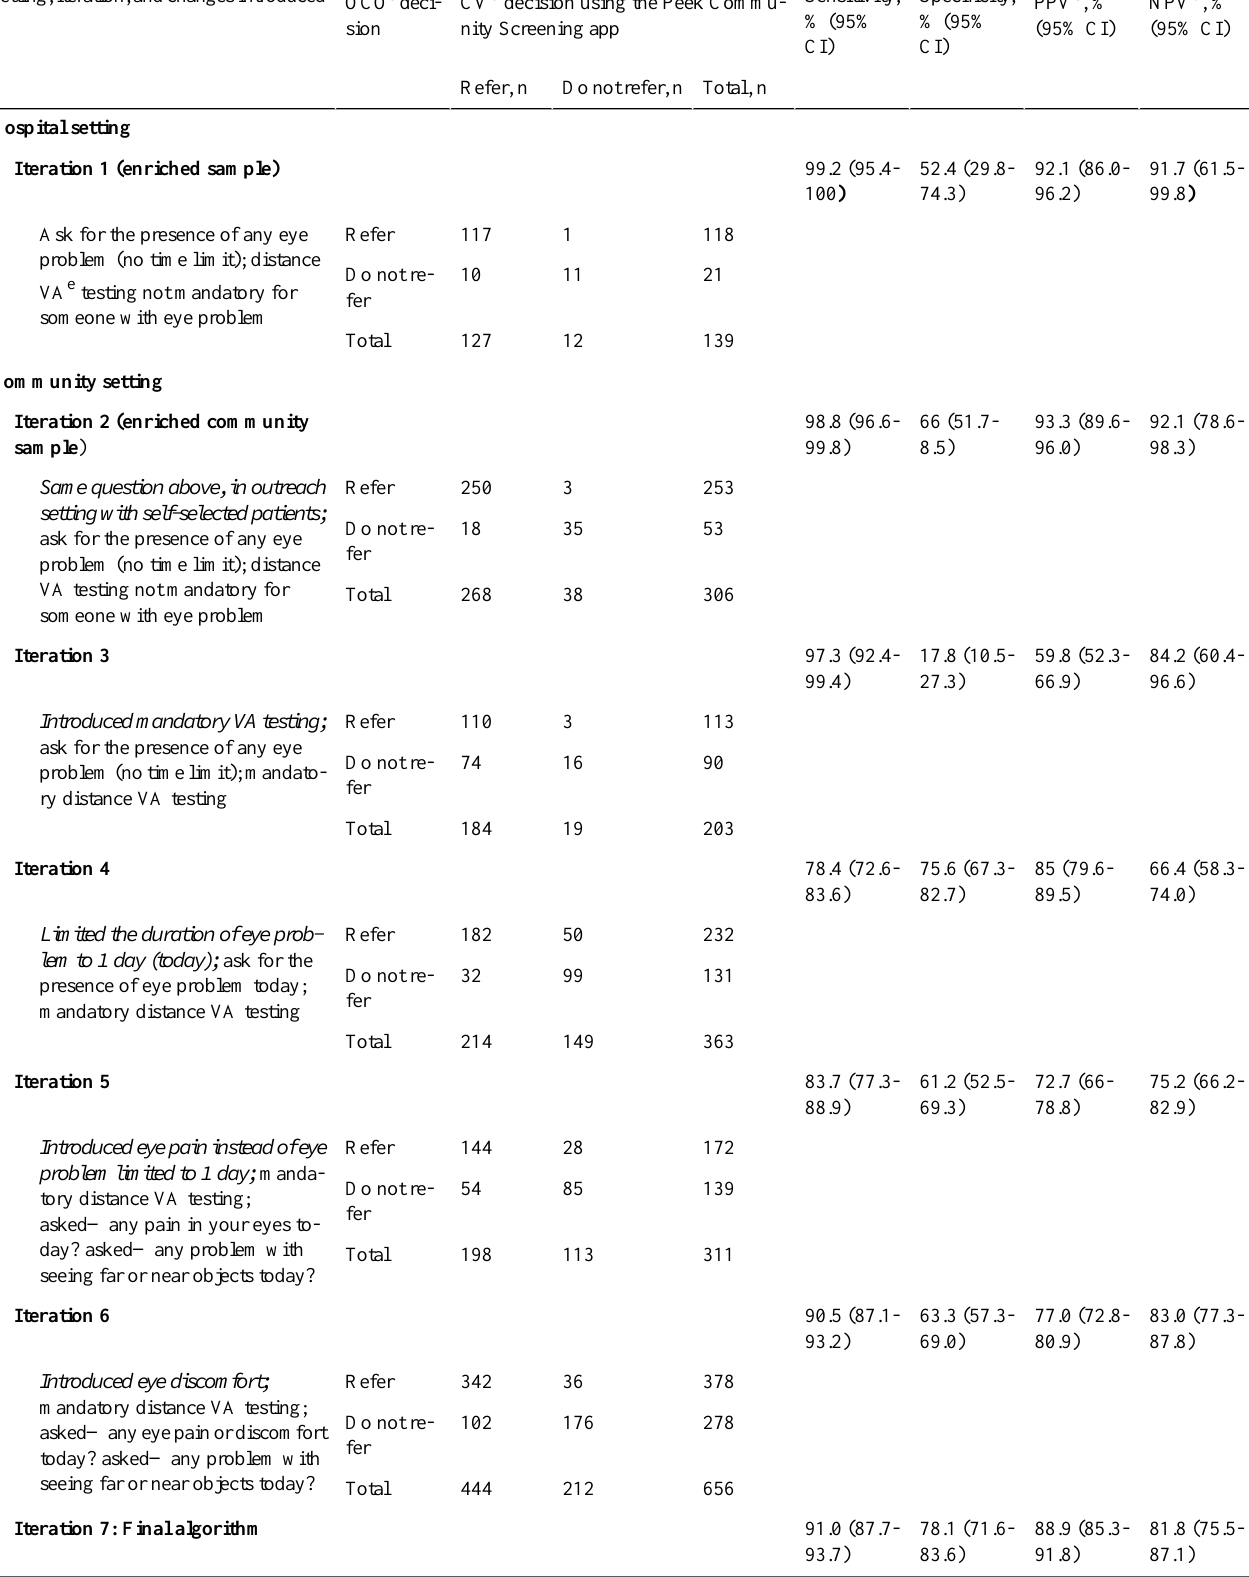
Table 1. Sensitivity and specificity of the Peek Community Screening app and the changes introduced at each iteration during